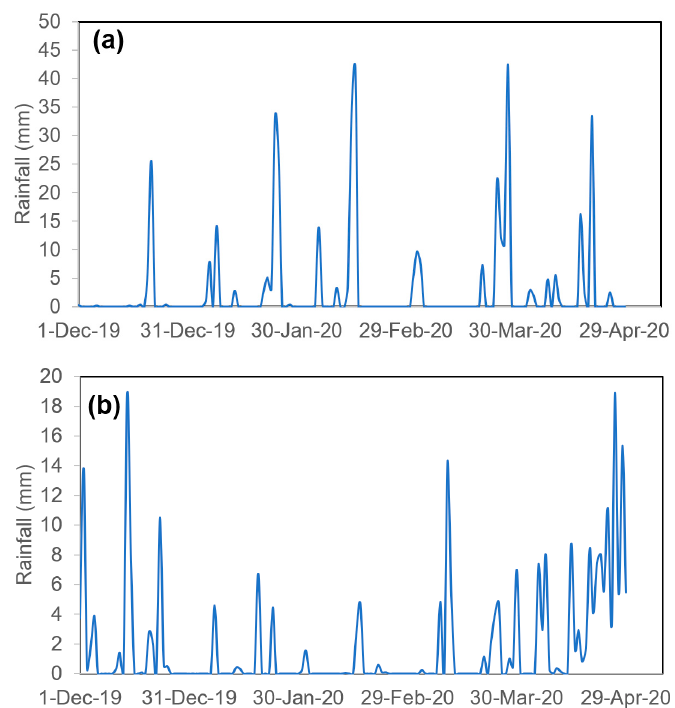
Figure 2. Daily precipitation (mm) time series chart for ( a ) Wuhan and ( b ) Vembanad (Cochin) during the study period (source: CHIRPS Daily: Climate Hazards Group InfraRed Precipitation with Station Data (version 2.0)).